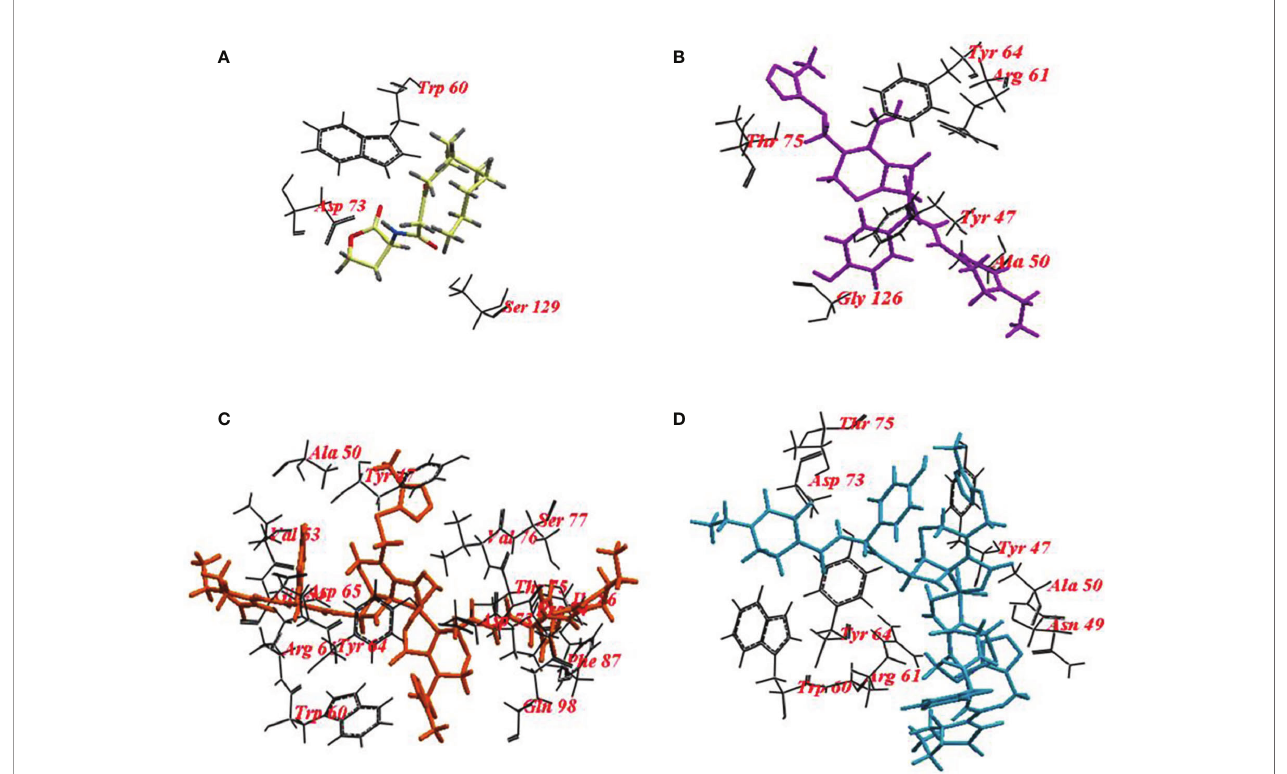
FIGURE 7 | Binding mode of (A) 3-oxo-C12-HSL cefoperazone; (B) Cefoperazone (CFP); (C) , Cefoperazone-Cobalt complex (CFPC) and (D) Cefoperazone-Iron complex (CFPF) and redocked into the active site of P. aeruginosa ligand-binding